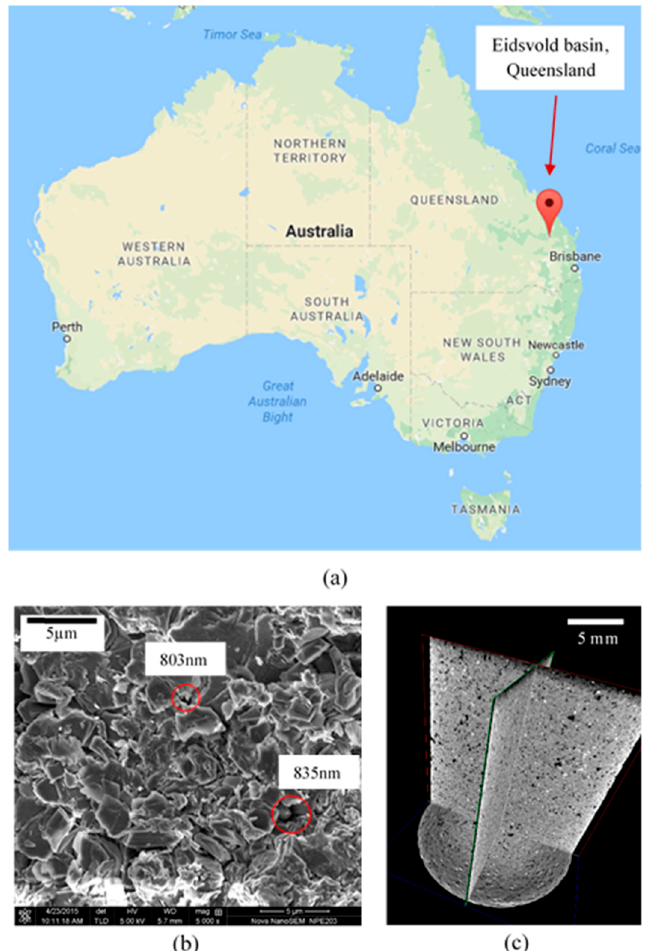
Figure 1. ( a ) Location of the Eidsvold basin (specimen location); ( b ) SEM analysis image of siltstone with pore size; ( c ) computed tomography (CT) scanning image with internal pore